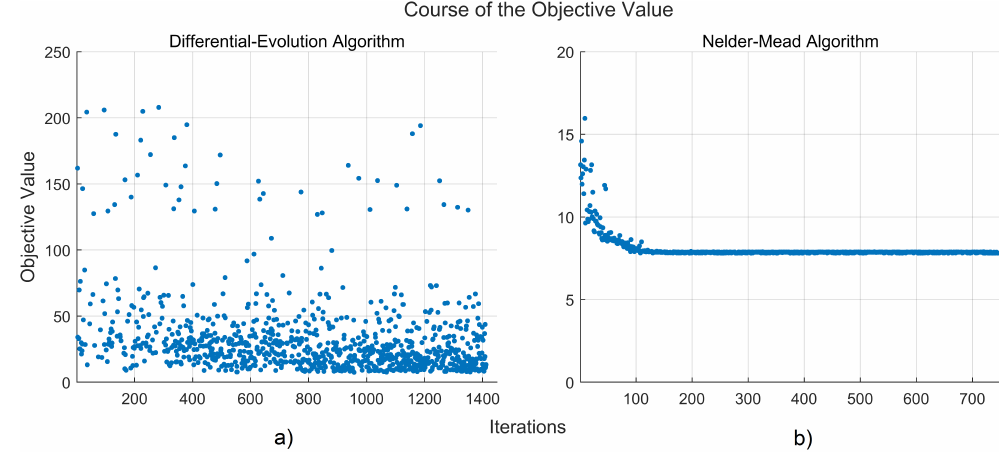
Figure 4. Course of the objective value from ( a ) differential-evolution and ( b ) Nelder–Mead Simplex Algorithm. Panel ( a ) shows a narrowing of the objective value for higher iterations. ( b ) The course of